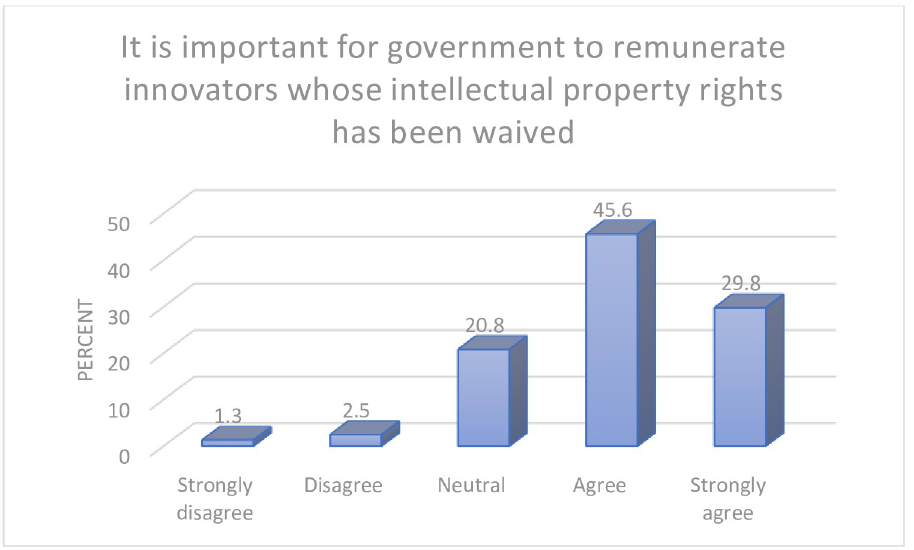
Fig 4. Incentives for intellectual property